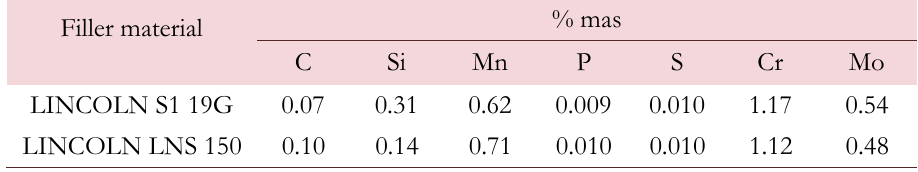
Table 3: Chemical composition of filler materials.